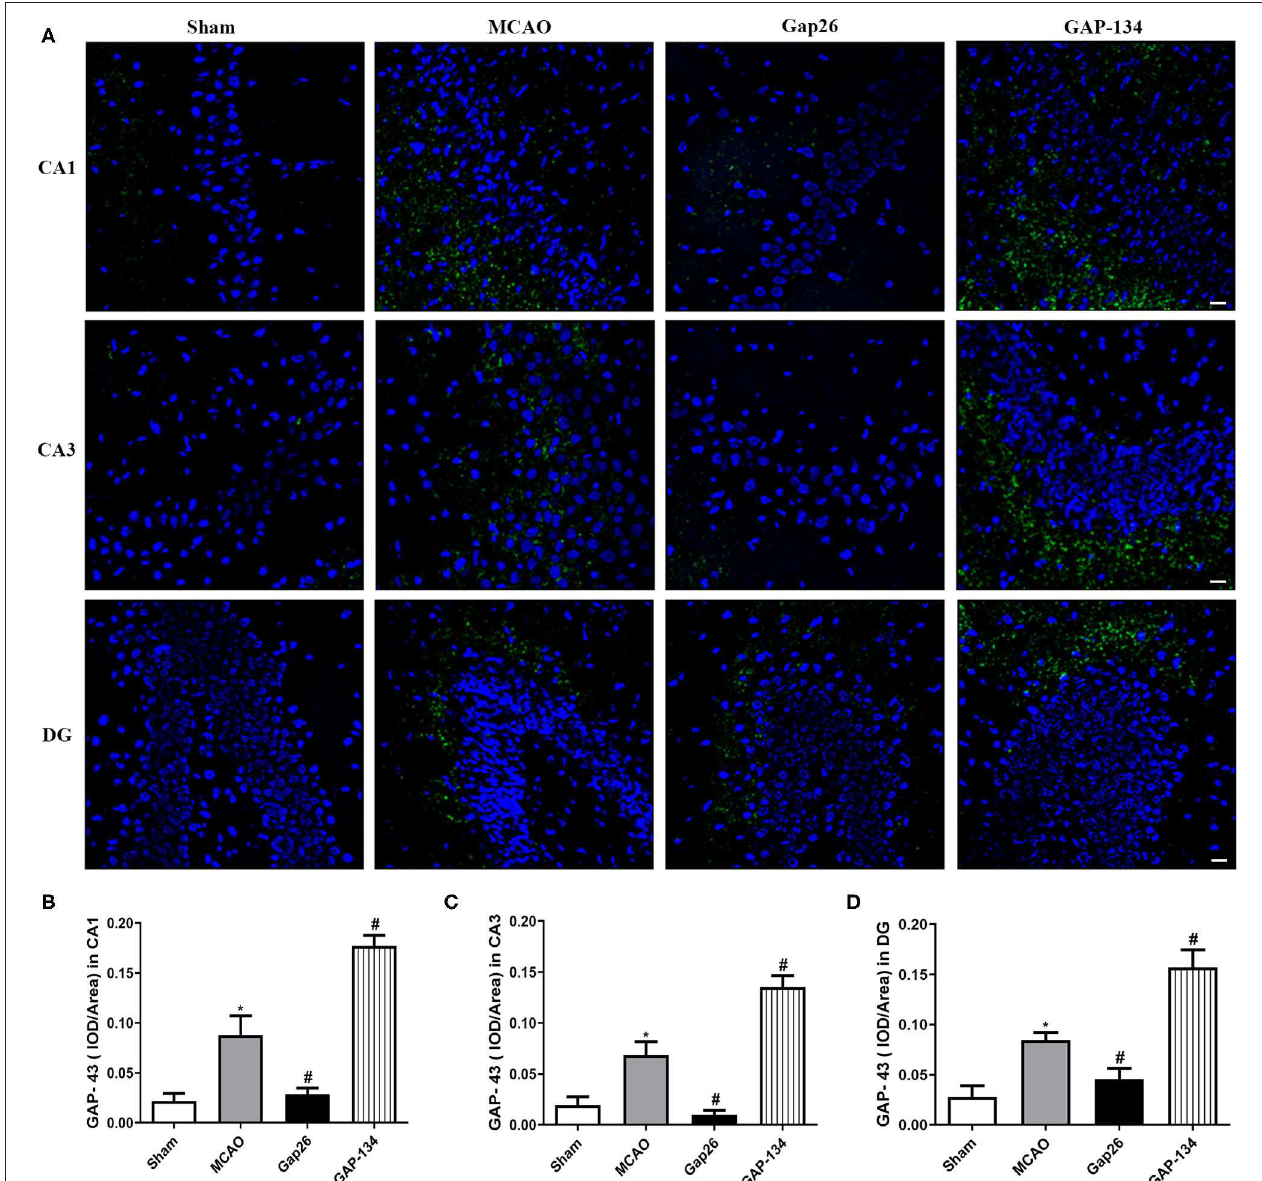
FIGURE 6 | Effects of Gap 26 and GAP-134 on the expression of GAP-43 at 7 d after MCAO. Data were shown as mean ± SEM, n = 6. (A) Representative pictures of GAP-43 in hippocampal CA1, CA3, and DG. Blue depicts staining of DAPI (cell nuclei), and green depicts staining of SYN. Scale bar = 20 µ m. (B–D) Quantitative analysis showed that the expression of GAP-43 was downregulated by Gap26 but upregulated by GAP-134 in hippocampal CA1, CA3, and DG (* P < 0.05 vs. sham, # P < 0.05 vs.